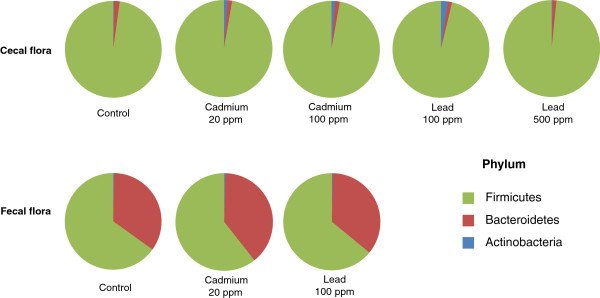
Distribution of bacterial phylotypes in the cecum content and fecal pellets of mice exposed for 8 weeks to Cd (20 or 100 ppm) or Pb (100 or 500 ppm) salts via their drinking water. 16S rRNA-base analyses were derived from 454/Roche multitag pyrosequencing. Data are expressed as the mean percentage abundance of the total assignment (n = 5 animals per group). In line with the literature data, most of the bacteria in untreated (control) mice belonged to Firmicutes or the Bacteroidetes, whereas Actinobacteria were very rare.